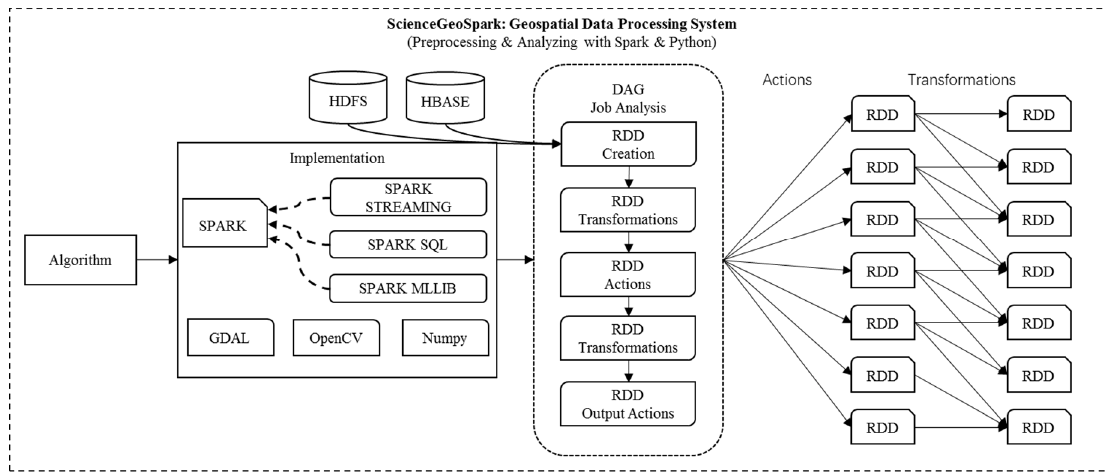
Figure 5. Programming model with Spark and Python.